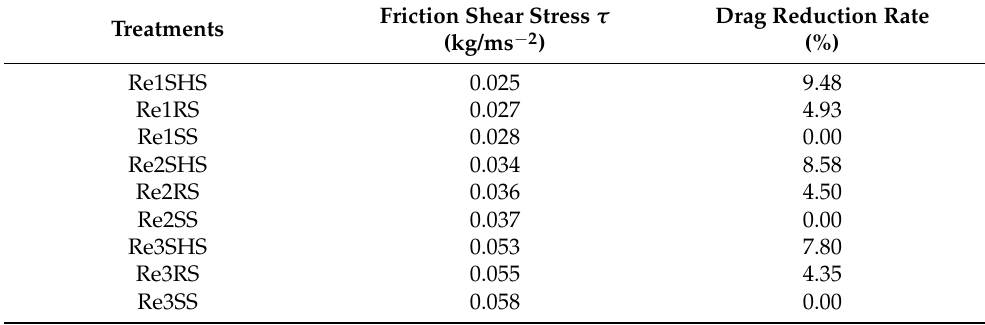
Table 3. Drag reduction rate of microstructured surfaces at different experimental